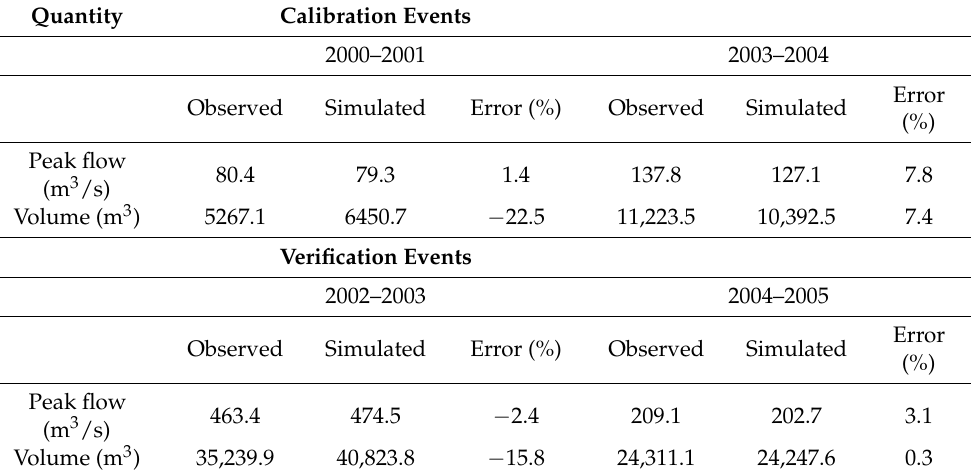
Table 6. Errors in simulated flood peak flow and flood volume (HEC-HMS model).